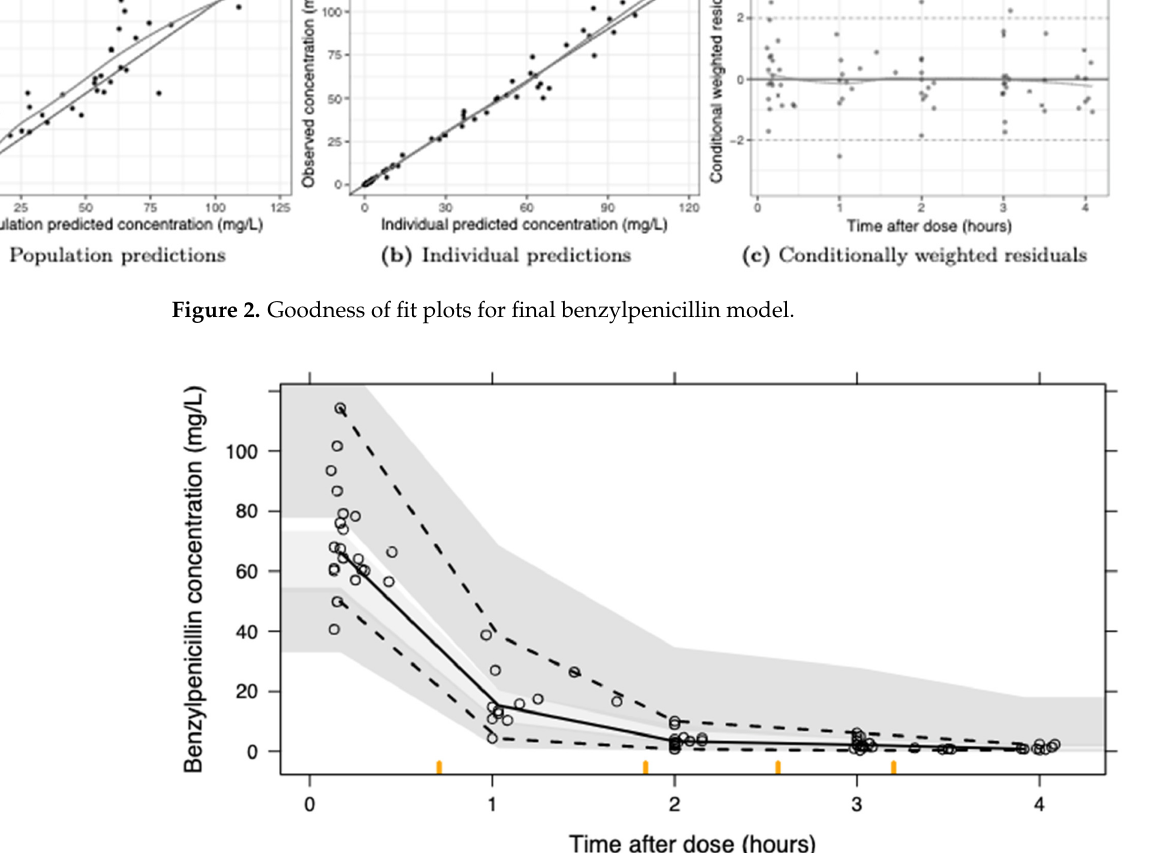
Figure 3. Final model prediction-corrected visual predictive check simulated to 4 hours. The predic- tion-corrected observed data is represented by the solid line, with the dashed lines representing the 95% confidence interval. The orange marks along the x-axis represent the binning of the time do- main. Simulations of four dosing strategies were performed to estimate %fT>MIC at vari- ous MIC values. Dosing strategies simulated included (a) standard dosing of 1.2 g bolus 4-hourly, (b) 2.4 g bolus 4-hourly, (c) 1.2 g bolus followed by 6 g continuous infusion over 24 h, (d) 7.2 g continuous infusion over 24 h, and (e) 1.2 g extended infusion over 2 h, 4- hourly. The results are displayed in Figure 4, with median values for %fT>MIC with each dosing regimen presented in Supplementary Materials, Table S2.